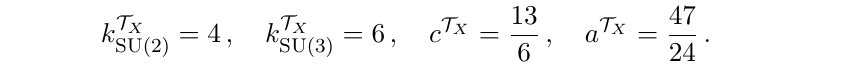
Figure 4 . The factorized form of the interacting T X